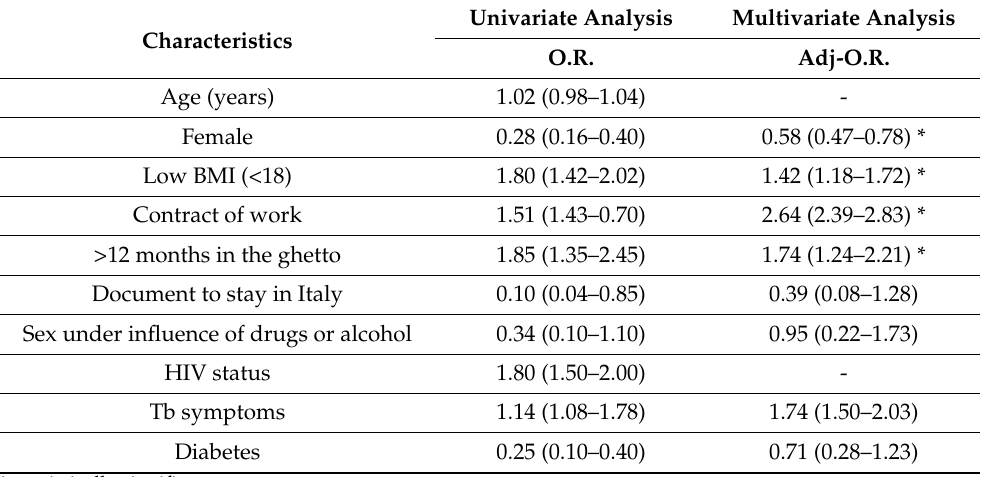
Table 4. Factors associated with presence of muscle and joint pain/fatigue in agricultural migrant